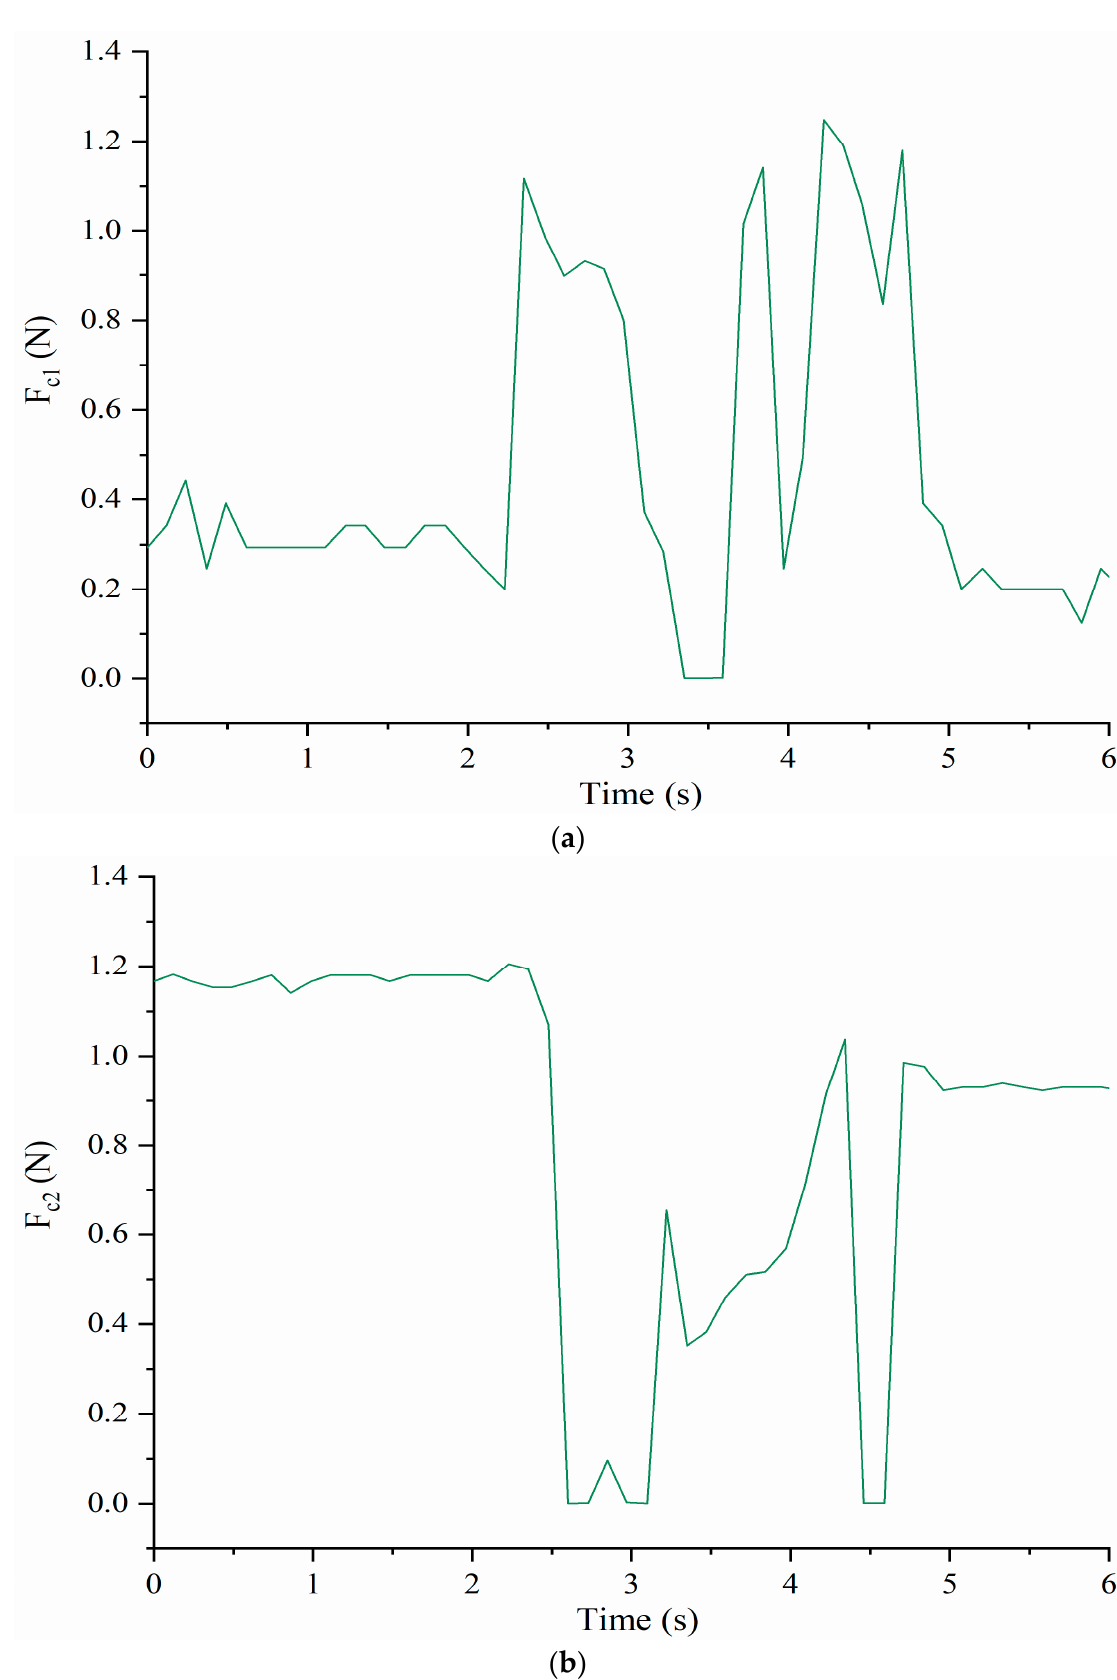
Figure 12. Acquired forces between the cables and shoulder body during full rotation: ( a ) F c1 ; ( b ) F c2.